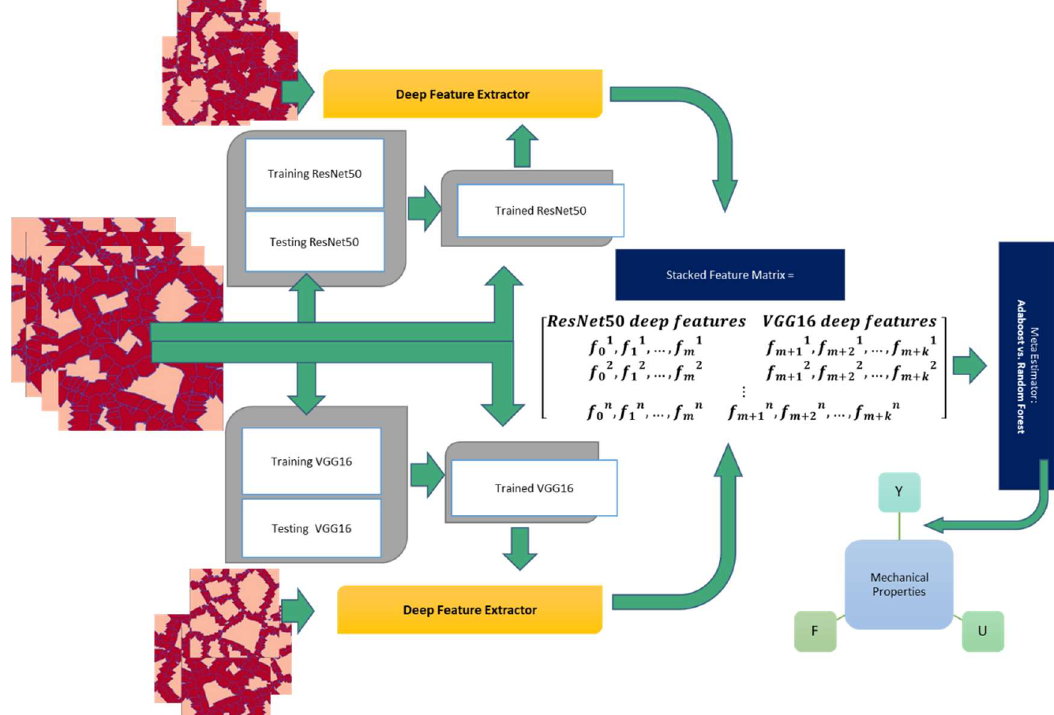
Figure 5. General framework of the hybrid model.